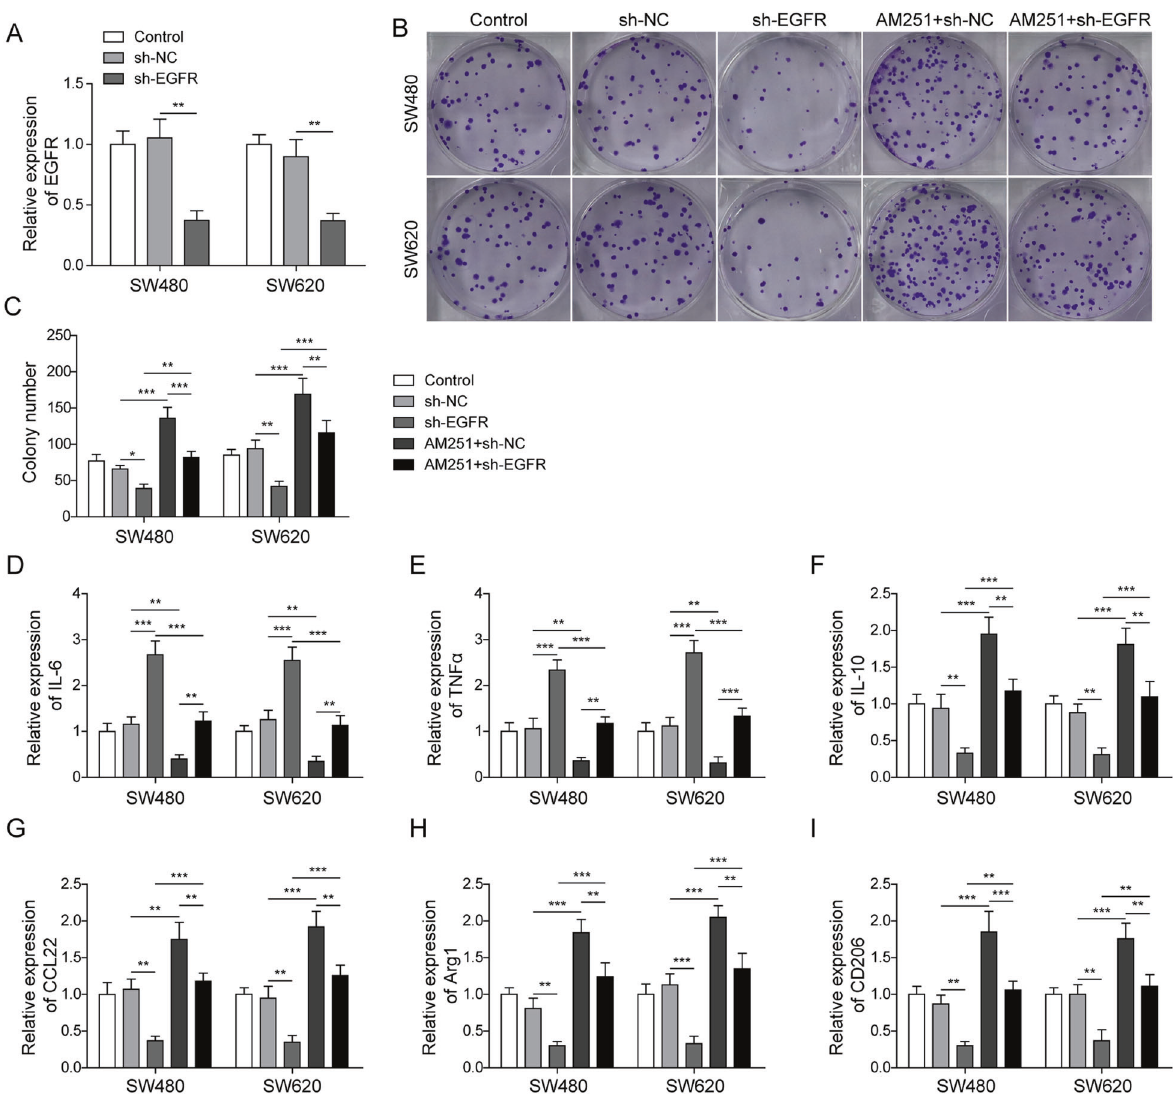
Fig. 6 EGFR knockdown reversed the effects of CB1 silencing on tumor cell growth and M2 macrophage polarization. Colorectal cells were transfected with plasmids bearing shRNA against EGFR and simultaneously treated with AM251. Culture medium for these colorectal cells were taken to incubate PMA-induced THP-1 cells. A QPCR analysis showed that sh-EGFR effectively suppressed the expression of EGFR. B , C Colony formation test demonstrated that EGFR knockdown reversed the enhancement in colony formation induced by AM251. D – I QPCR results demonstrated that EGFR knockdown reversed the CB1 inhibition caused decrease in the expression of IL-6 and TNF- α , and increase in IL-10, CCL22, Arg-1 and CD206. * P < 0.05; ** P < 0.01; *** P <